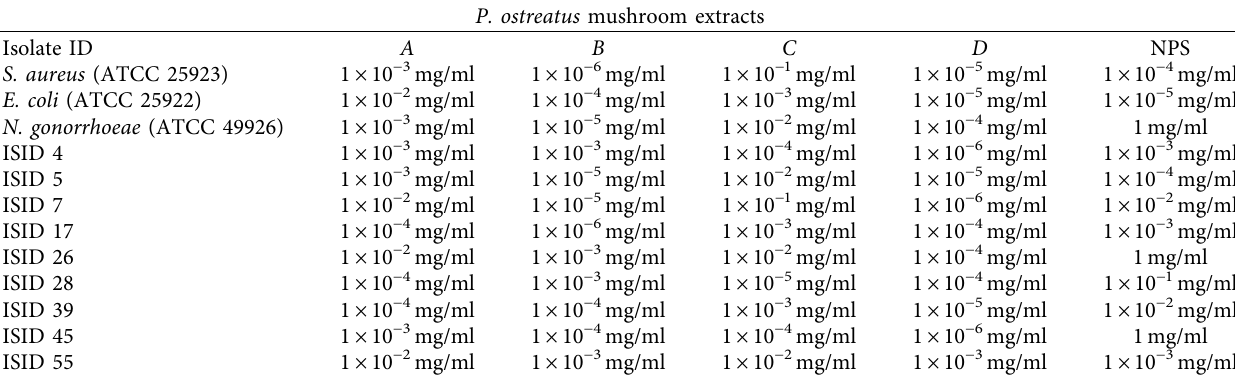
Table 2: MBC determined for P. ostreatus mushroom extracts antimicrobial properties against target bacteria.